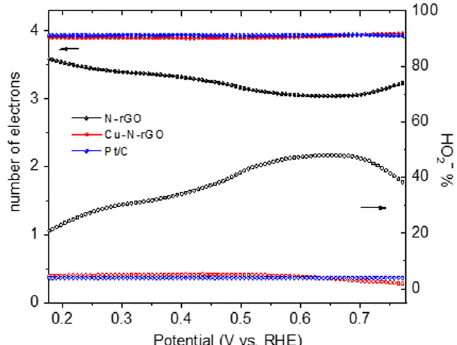
Fig. 9 Rotating ring disk electrode study. Number of electrons (left axis) and peroxide percentage (right axis) on graphene-based and reference Pt/C catalysts in air-saturated 0.1 M KOH